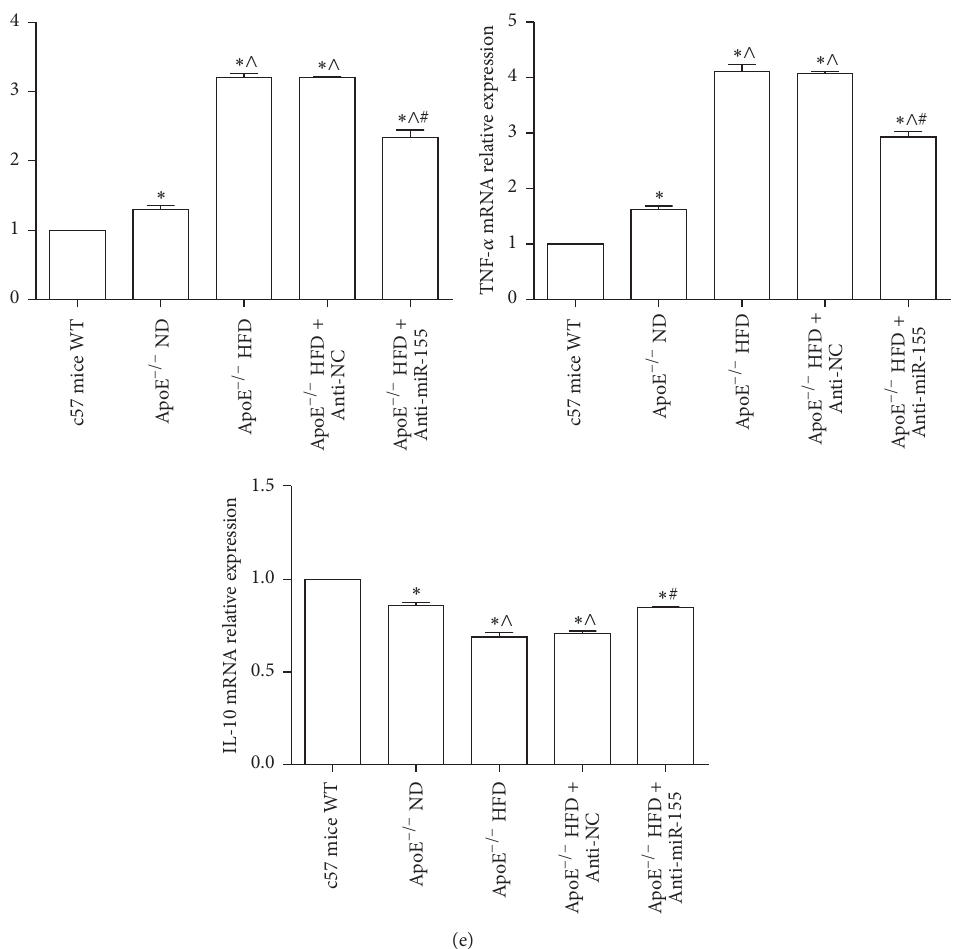
Figure7:InhibitionofmiR-155byAnti-miR-155decreasedtheatheroscleroticdevelopmentinApoE −/− micewithHFD(ApoE −/− HFDmice). (a) qPCR detected the miR-155 and CD68 mRNA expression in aortic tissue when ApoE −/− HFD mice were injected with anti-miR-155 and anti-NC. ∗ 𝑝 < 0.05 versus anti-NC. (b) Atherosclerotic plaques in the thoracoabdominal aorta of anti-miR-155 and anti-NC-injected ApoE −/− HFD mice were assessed by Oil Red O staining, and the plaques areas were quantified by using Imagepro-plus 7.0: ∗ 𝑝 < 0.05 versus anti-NC. (c) Western blot analyzed the protein level of SOCS1, p-STAT3, and PDCD4 in aortic tissue when ApoE −/− HFD mice were injected with anti-miR-155 and anti-NC for 2 weeks. Representative bands show the protein expression of SOCS1 (the upper bands), p-STAT3 (the middle bands), PDCD4 (the third bands), and 𝛽 -actin (the lower bands) in the left panel, and the histograms in the right panel show quantification of the bands’ normalization relative to 𝛽 -actin expression in (c). The data are presented as the mean ± SE of three separate experiments: ∗ 𝑝 < 0.05 versus anti-NC. (d) The plasma level of IL-6, TNF- 𝛼 , and IL-10 of anti-miR-155 and anti-NC-injected ApoE −/− HFD was detected by the ELISA kit ( 𝑛 = 4 ): ∗ 𝑝 < 0.05 versus ApoE −/− HFD group, ∧ 𝑝 < 0.05 versus anti-NC-injected ApoE −/− HFD group. (e) qPCR analyzed the expression of IL-6, TNF- 𝛼 , and IL-10 of c57 mice, ApoE −/− ND, ApoE −/− HFD, anti-miR-155, and anti-NC-injected ApoE −/− HFD mice in aortic tissue ( 𝑛 = 4 ): ∗ 𝑝 < 0.05 , relative to c57 mice WT, ∧ 𝑝 < 0.05 , relative to ApoE −/− ND, # 𝑝 < 0.05 , relative to ApoE −/−